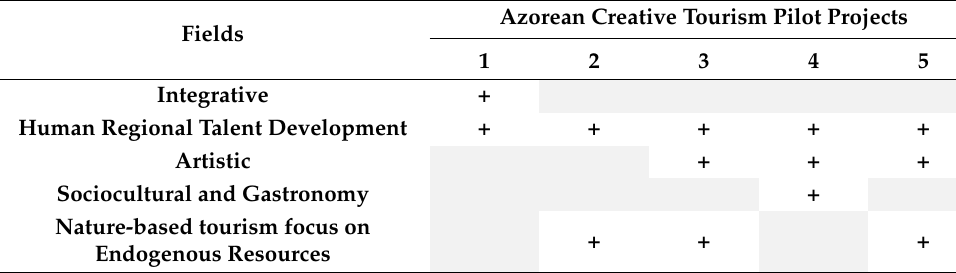
Table 3. Azorean creative pilot projects by fields.